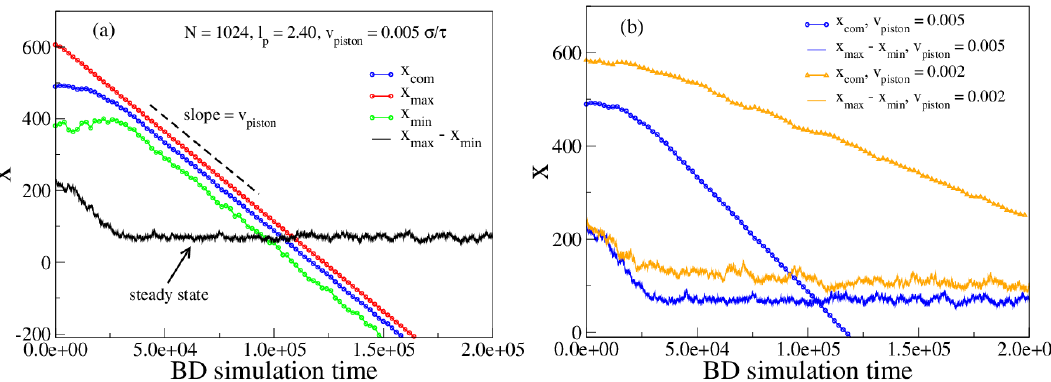
Figure 2. ( a ) The evolution of the maximum (green), minimum (red) and the x -coordinate of the center of mass (COM) (black) (along the channel axis) during the simulation are shown, the extension of the chain The piston is approached from the x max side. When the COM’s speed becomes the same as V push , the steady state of the polymer chain is achieved; ( b ) The same as in ( a ) but compares the effect of two different piston speeds 0.005 and 0.002